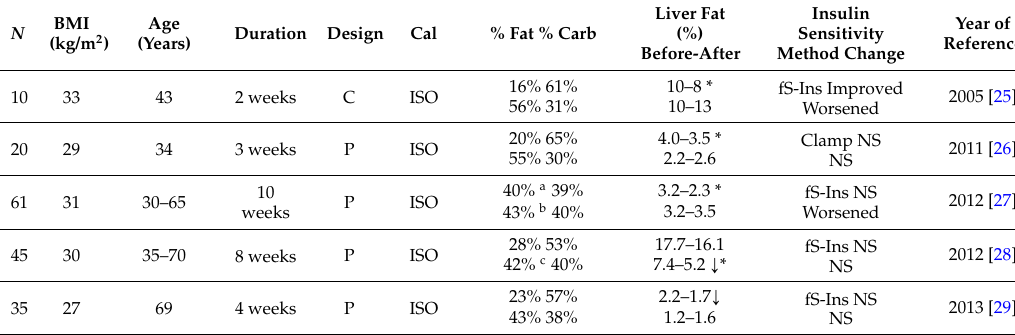
Table 1. Studies comparing effects of low fat-high carbohydrate and high fat-low carbohydrate on liver fat and insulin